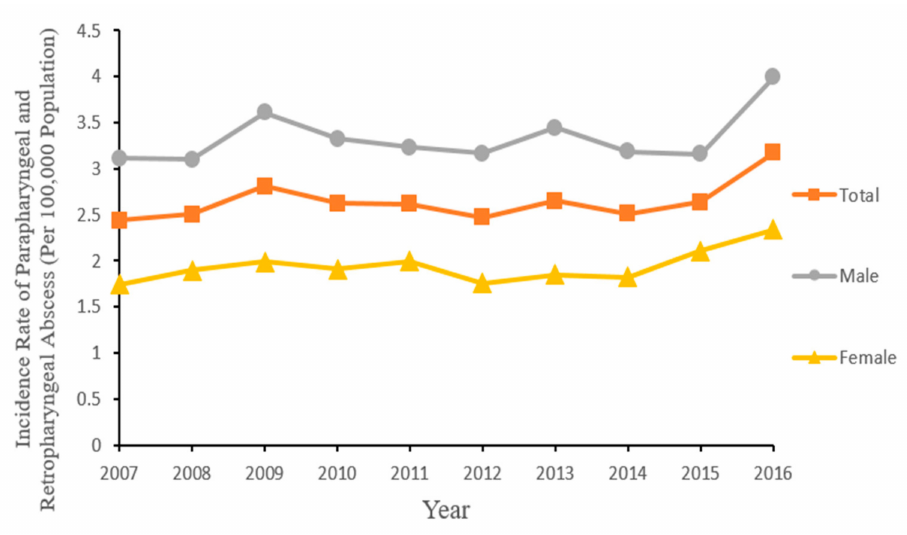
Figure 1. Annual incidence rates of parapharyngeal and retropharyngeal abscess in Taiwan by gender during 2007–2016.